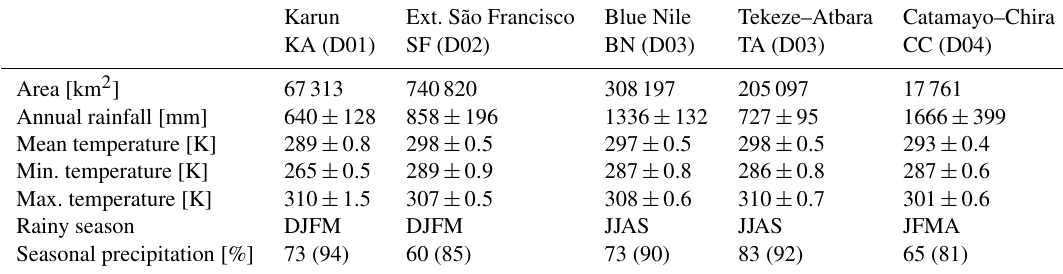
Table 1. Overview and basic characteristics of the five river basins with climate data from ERA5-Land. In addition to the yearly mean temperature, the yearly temperature range is given by the monthly minimum and maximum temperature in brackets. The main 4 months of the rainy season are provided, and the respective seasonal precipitation is given as a share of the total annual precipitation. In brackets, the percentage of precipitation of the 6-month rainy season (1 month prior to and after the main 4 months) is also